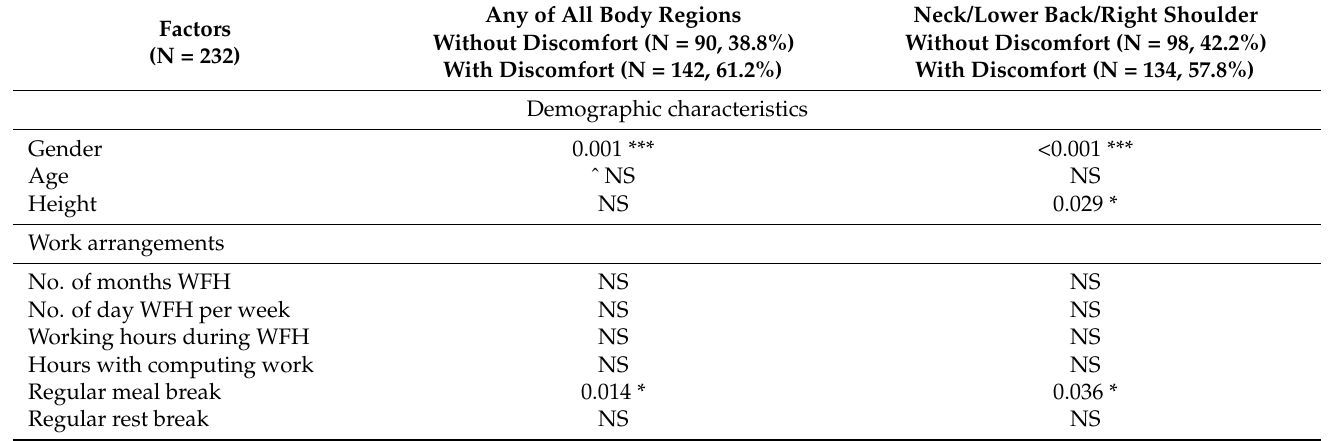
Table 5. Summarised results of demographic characteristics and work arrangement factors associated with musculoskeletal discomfort.